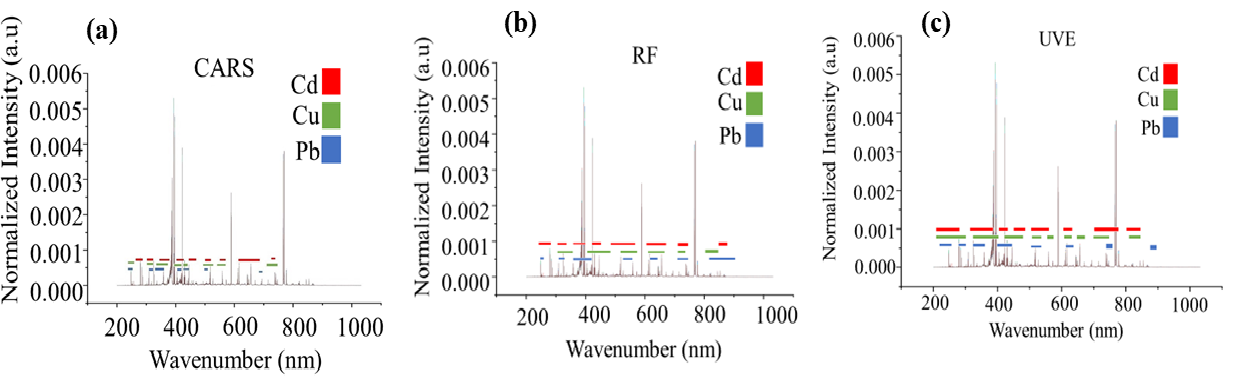
Figure 7. ( a ) Distributions of selected wave number by CARS ( b ) Distributions of selected wave number by RF ( c ) Distributions of selected wave number by UVE